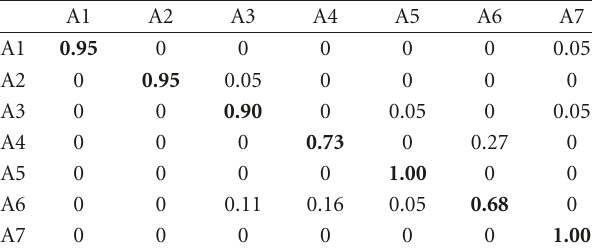
Table 4: Confusion matrix at resolution level 3.